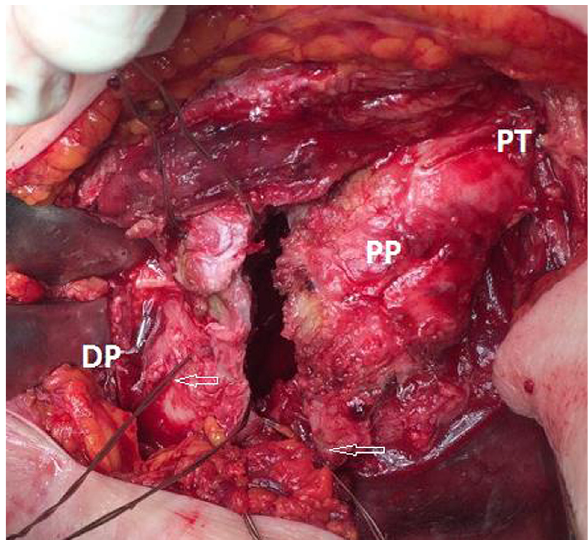
Figure 1. Determination of femur length, fixation of greater trochanter by tension band wires.